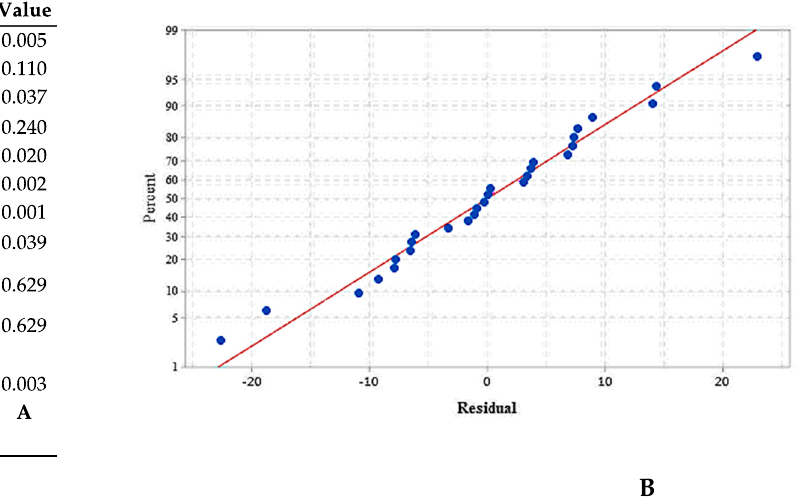
Figure 10. Analysis of variance (ANOVA) for the RSM ( A ) and normal probability plot of the residuals of GCD-2/CIT EO ( B ). Contour plot present in Figure 11 illustrates the level of parameters that allowed to reach the maximum of retention (>10%) which was found with a stirring during around 60 min at a rate of 1500 rpm.